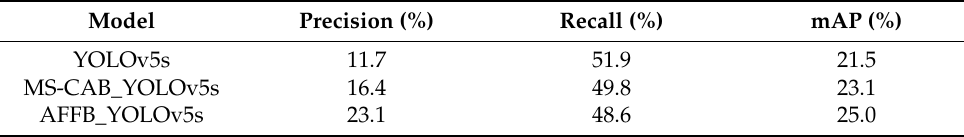
Table 3. Comparison of models on small object detection performance.